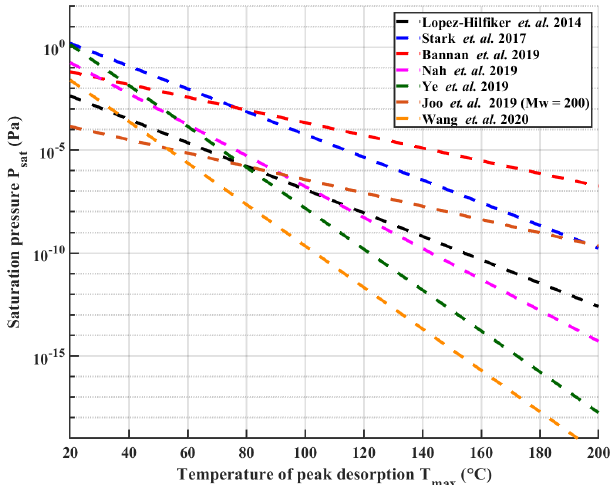
Figure 1. Previously reported calibration measurements with tem- perature at peak desorption ( T max ) plotted against saturation pres- sure P sat . The Joo et al. (2019) line has been converted from satu- ration concentration values to saturation pressure assuming a molar mass of 200. All lines except Joo et al. (2019) are also refitted from literature data using the fitting routine described in Sect. 2.5. It is notable that in most cases the data points used for the fitting do not reach T max values higher than 120 ◦ C, which is likely partially re- sponsible for the large divergence of results when extrapolating to higher T max . Error bars of the fits are omitted for sake of